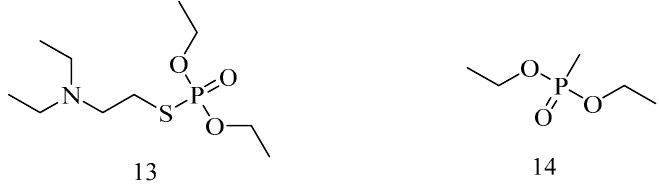
Figure 6. Amiton and Diethyl methylphosphonate (DEMP).